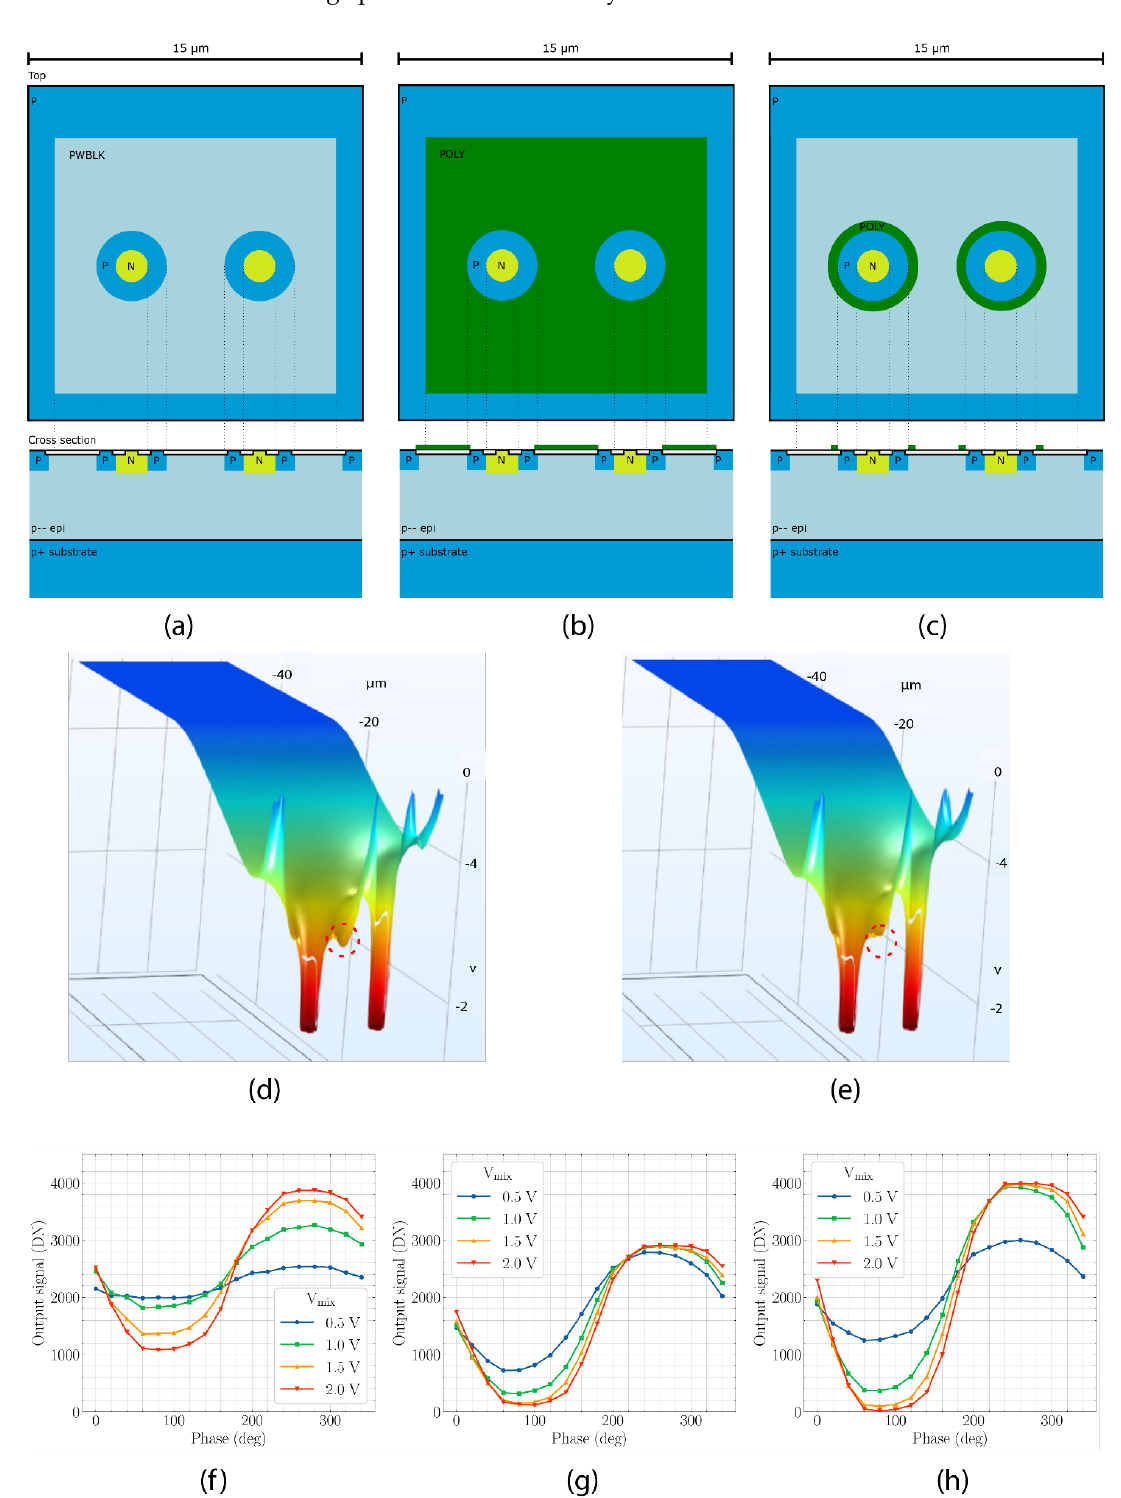
Figure 12. CAPD with a ring contact without a top polysilicon electrode ( a ), with a top polysilicon electrode ( b ), with a donut electrode ( c , d ) illustrates electrostatic potential under STI for device ( a , e ) illustrates electrostatic potential under STI for device ( b , c ) with a negative bias applied to the top electrode; ( f – h ) show measurement results of CAPD windowing function rect CAPD for ( a – c )